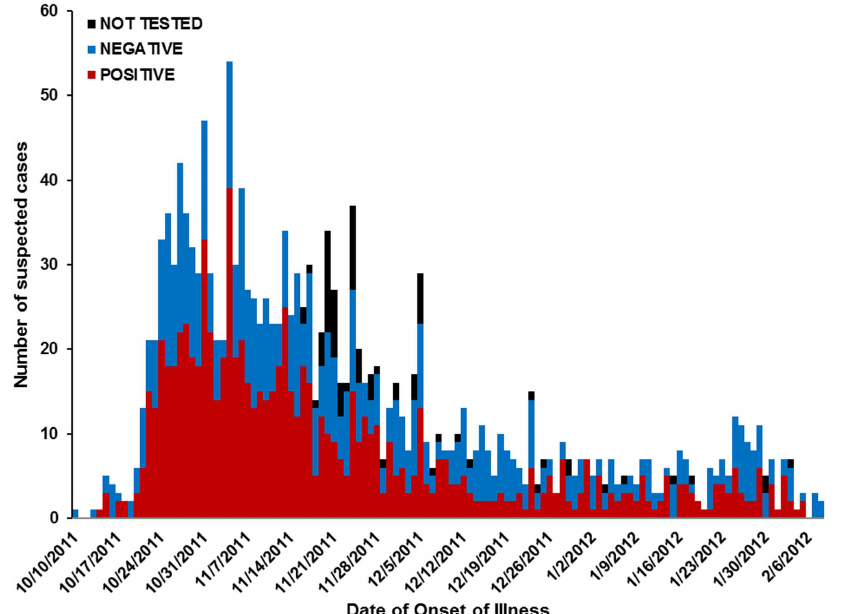
Figure 1. Epidemic curve of suspected dengue cases by date of illness onset in the Republic of the Marshall Islands, October 2011– February 2012. Laboratory case definition and date of illness onset were compiled as indicated. Only one date per week is shown on the x-axis.